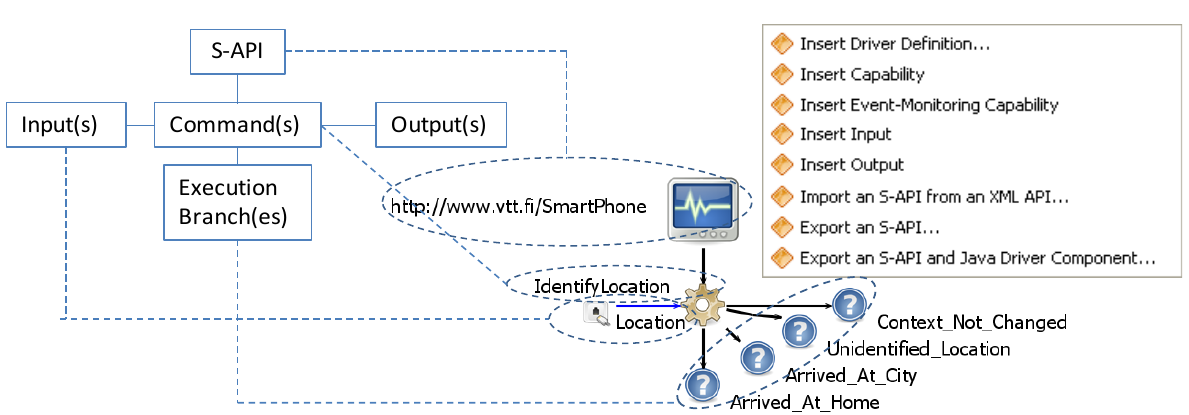
Figure 4. The Smart Modeller is used for the modeling of S-APIs.